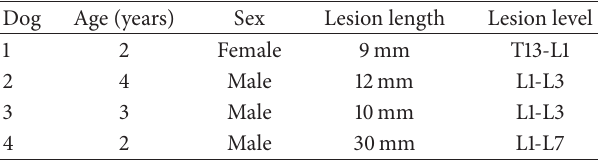
Table 1: Characteristics of dogs submitted to MSC